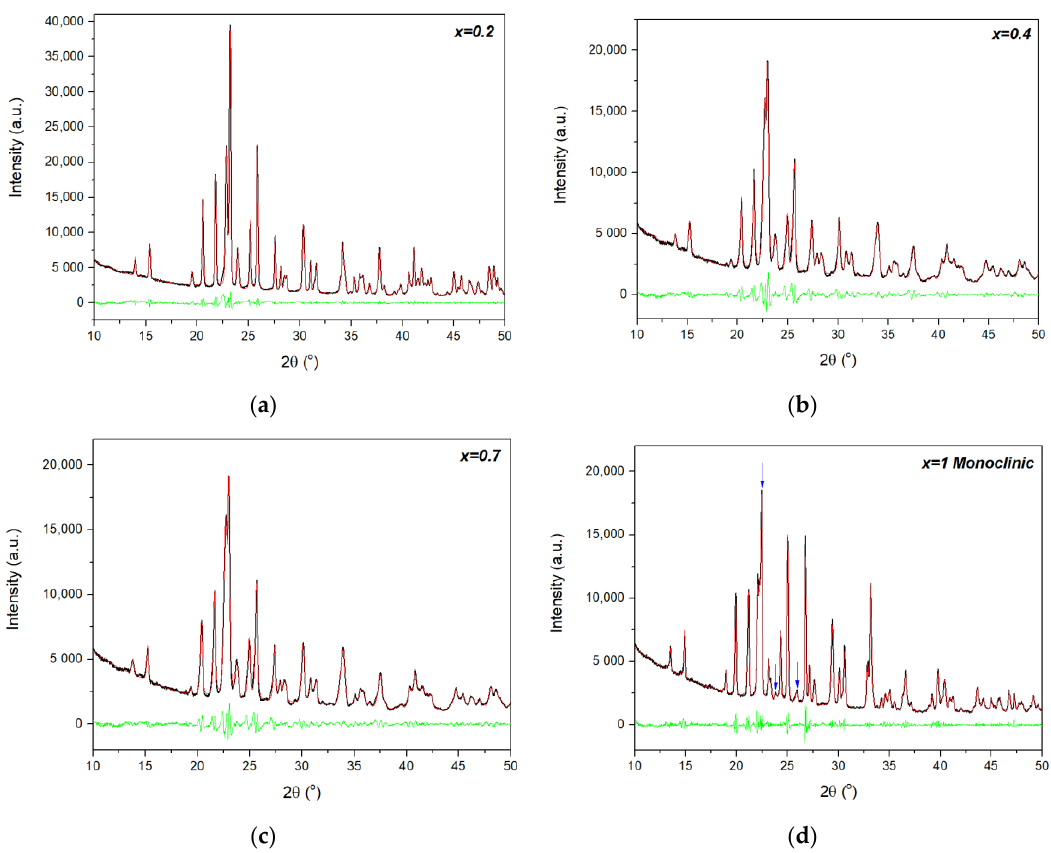
Figure 1. XRPD patterns of Al 2− x In x W 3 O 12 powders at RT, illustrating Le Bail fits to the orthorhombic Pbcn space group for the compositions ( a ) x = 0.2, ( b ) 0.4 and ( c ) 0.7 and to the monoclinic P2 1 /a space group for ( d ) x = 1 (to highlight the differences between orthorhombic and monoclinic patterns, the 2 θ angle range between 10 ◦ and 50 ◦ is presented). Experimental profiles are represented by black lines, calculated profiles by red lines and difference profiles by green lines. ( d ) The arrows show typical diffraction lines for the monoclinic system in the A 2 M 3 O 12 family, which are absent in the orthorhombic system.